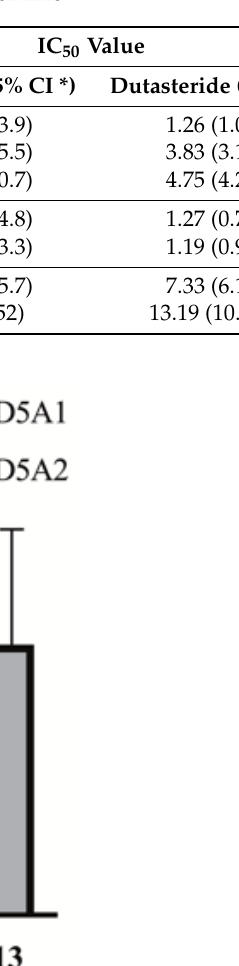
Table 3. IC 50 values of finasteride and dutasteride in each cell line.